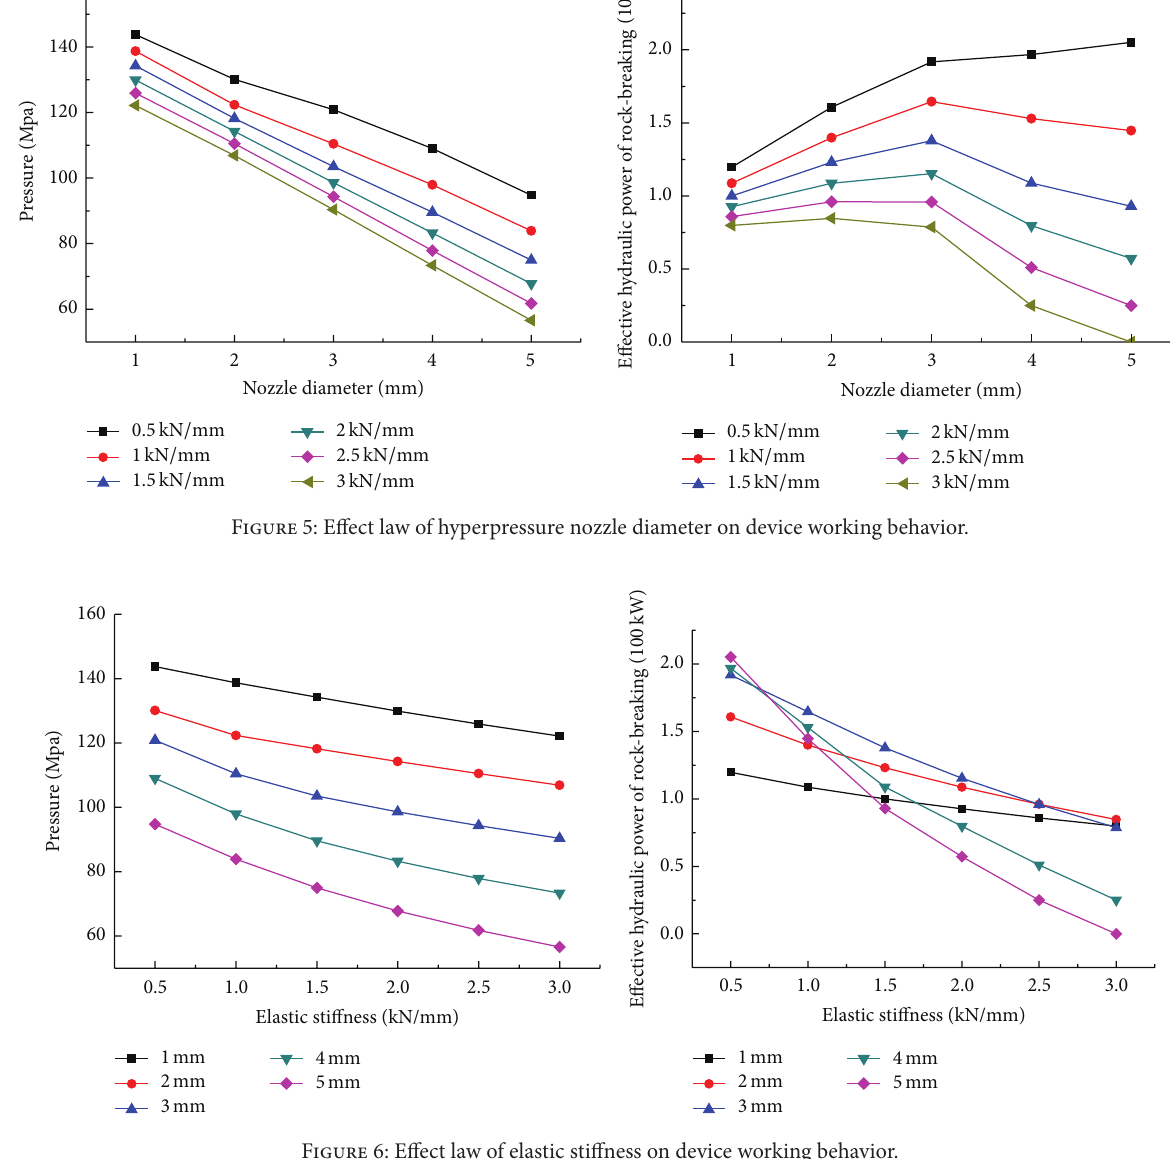
Figure 6: Effect law of elastic stiffness on device working